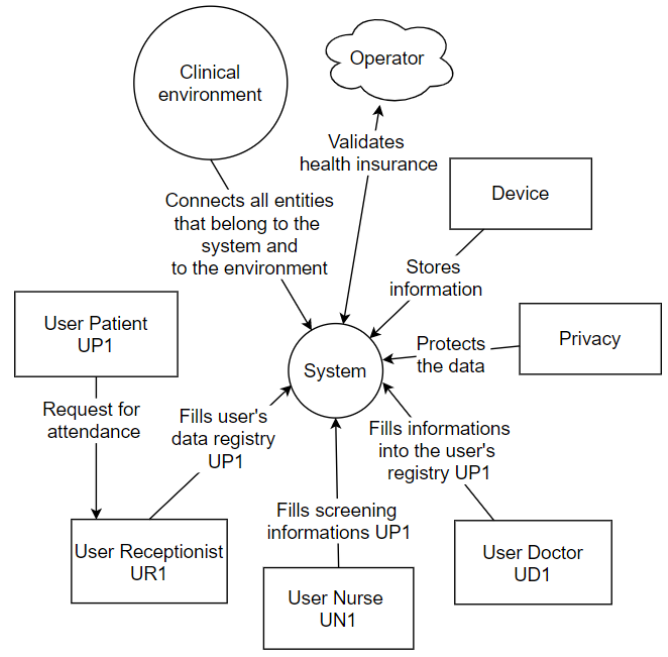
Figure 9. Context